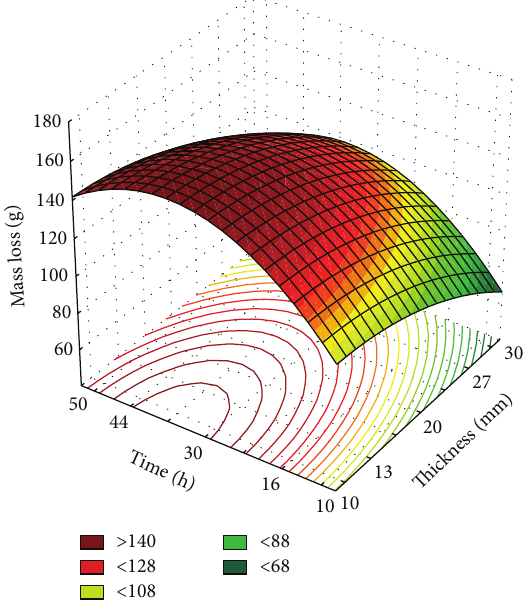
Figure 4: Response surface for tomato dehydration fixing the tem- perature variation level at 60 ∘